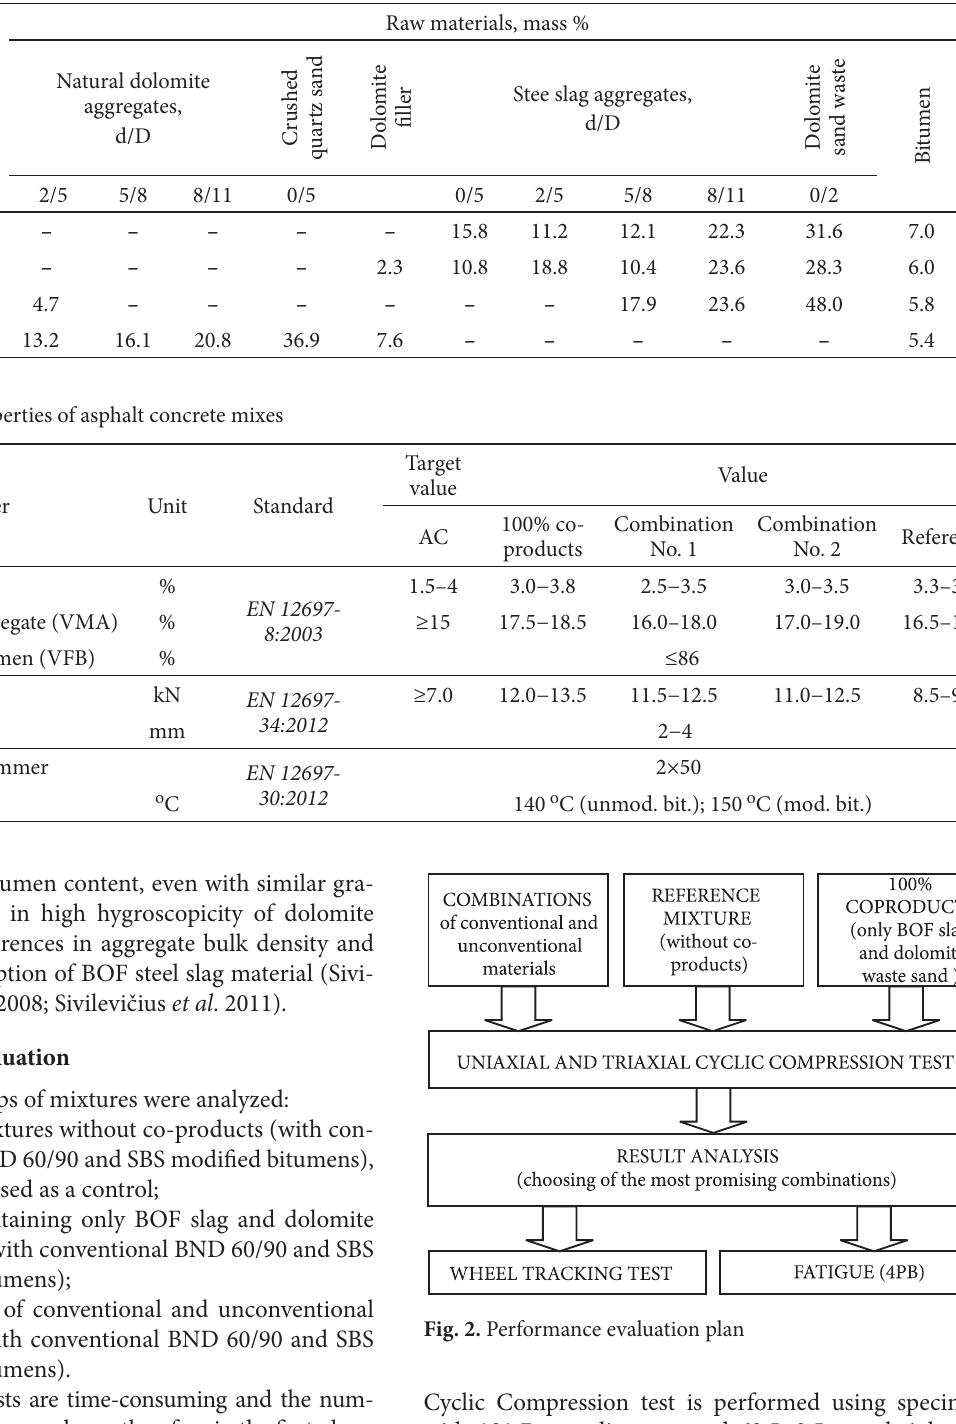
table 5. Compositions of asphalt concrete AC 11 mixes